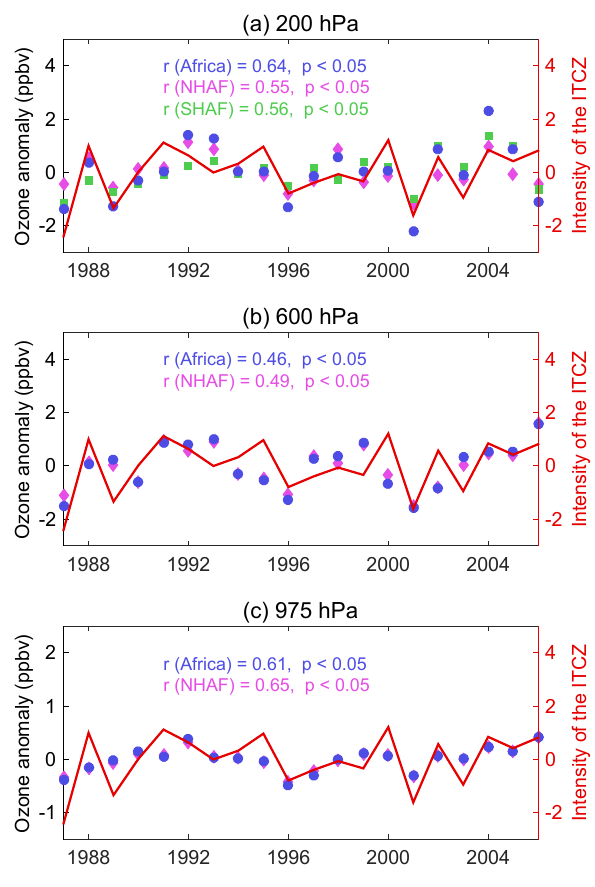
Figure 14. Interannual variation of the intensity of the ITCZ (the values are normalized) over Africa and the anomaly of imported ozone from Africa, NHAF, and SHAF over Asia from 1987 to